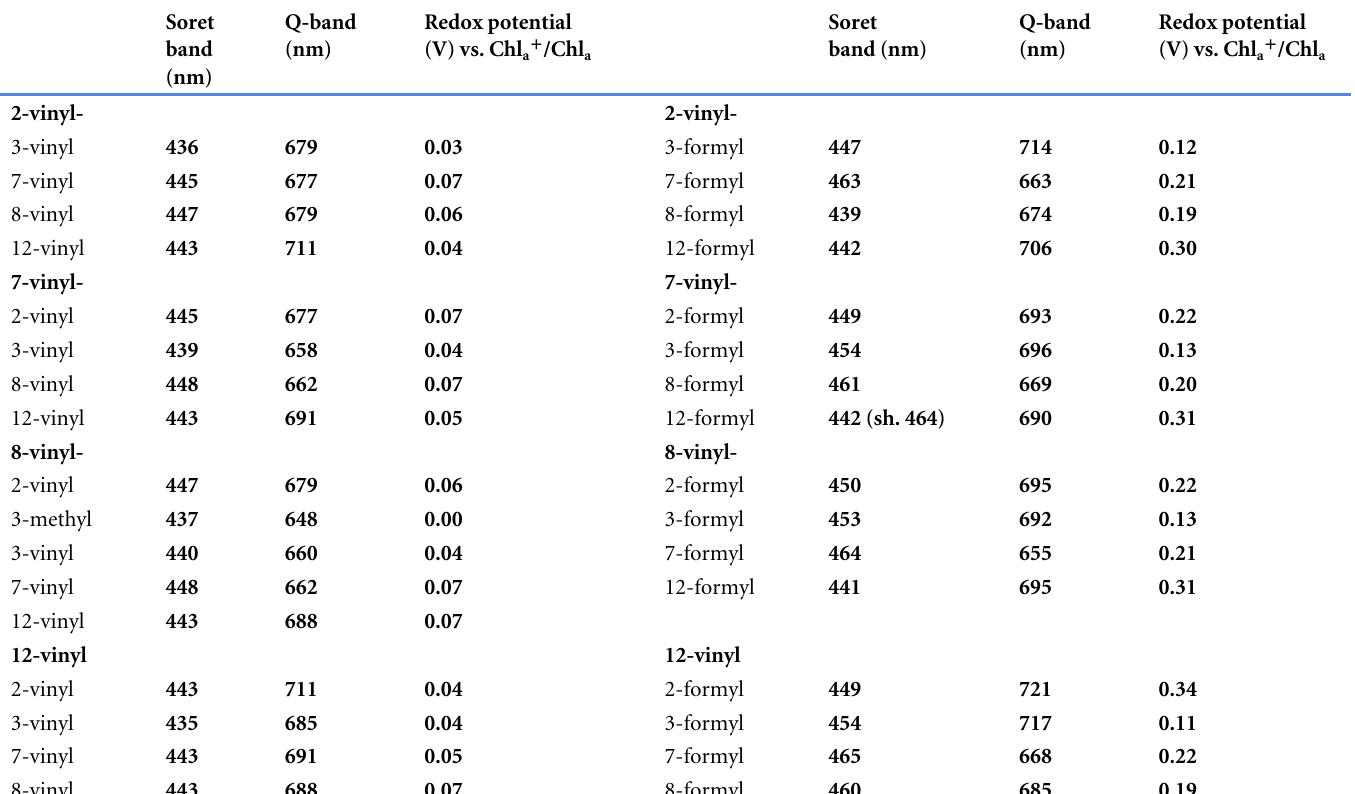
Table 3 Predicted wavelengths of the maxima of Soret and Q-bands of double-substituted chlorophylls bearing at least one additional vinyl group. Band positions were computed by taking the positions of the maxima of the TDDFT-computed spectra (B3LYP/6-311G(d,p) and transform- ing them according to the linear relationships between experimental and computational maximum absorption energies described in the first para- graph of the Results section. (sh.: